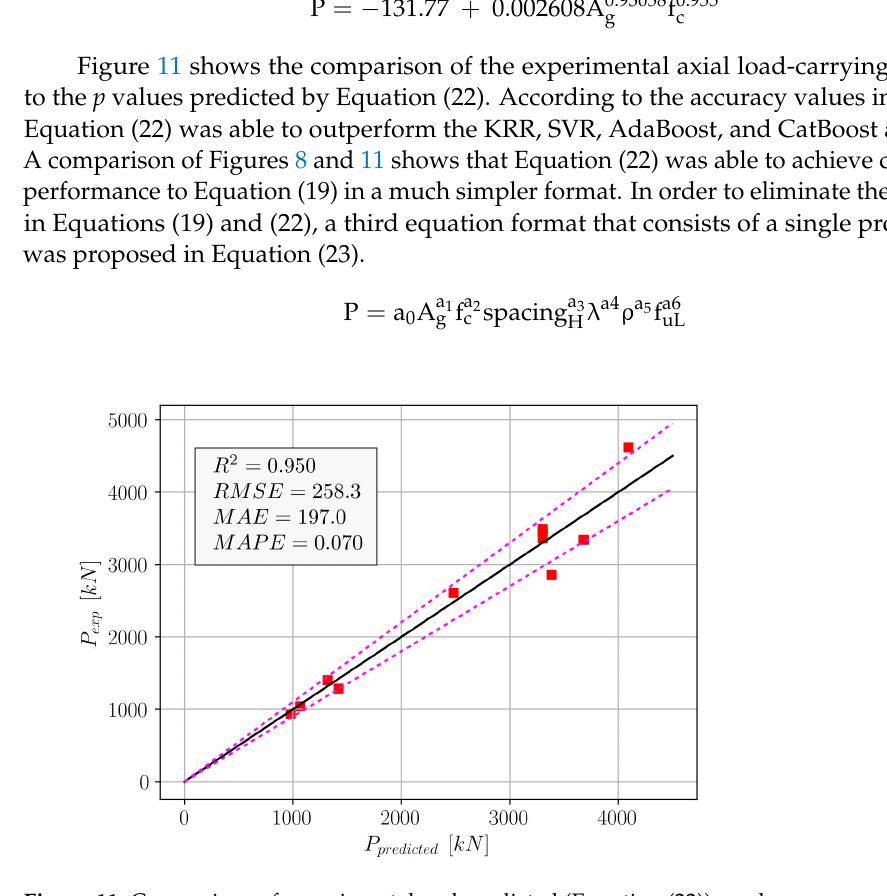
Figure 11. Comparison of experimental and predicted (Equation (22)) p